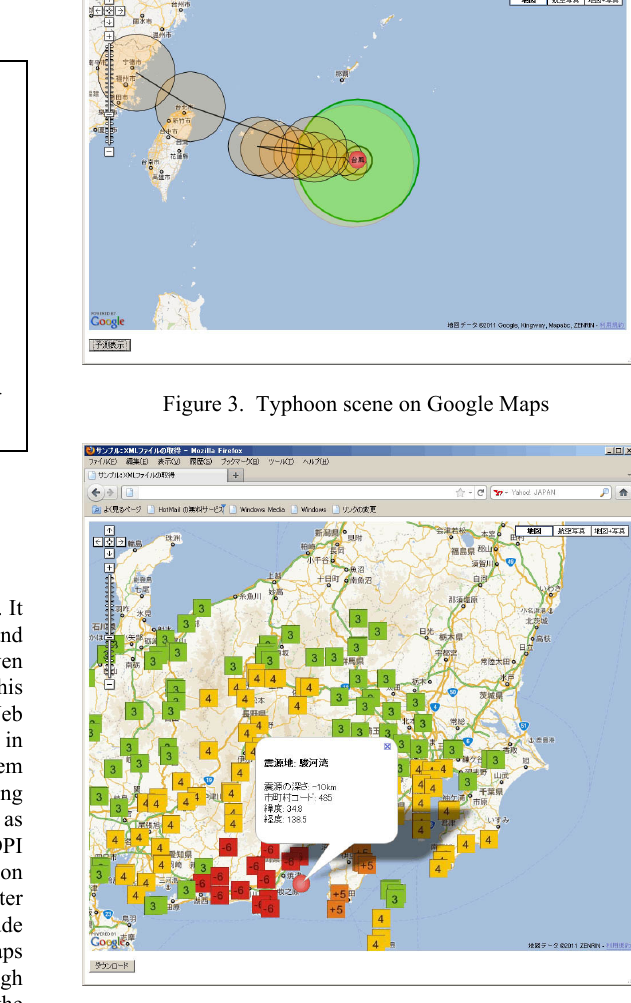
Figure 4. Earthquake scene on Google